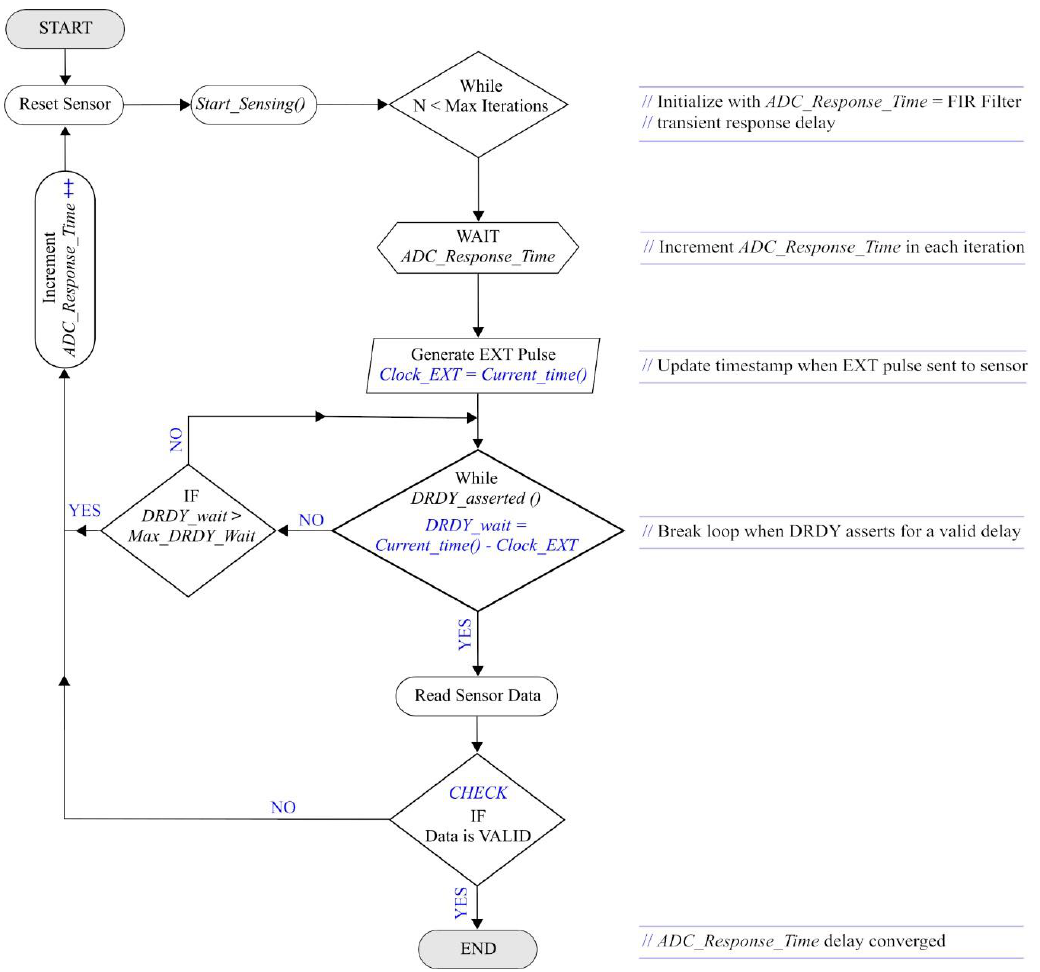
Figure 6. Analog to Digital Converter (ADC) startup delay estimation algorithm.